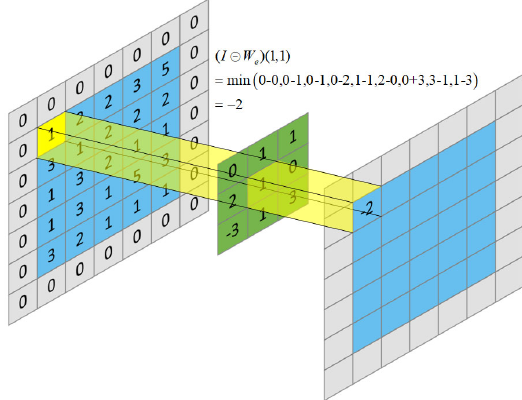
Figure 4. Example diagram of an erosion operation.